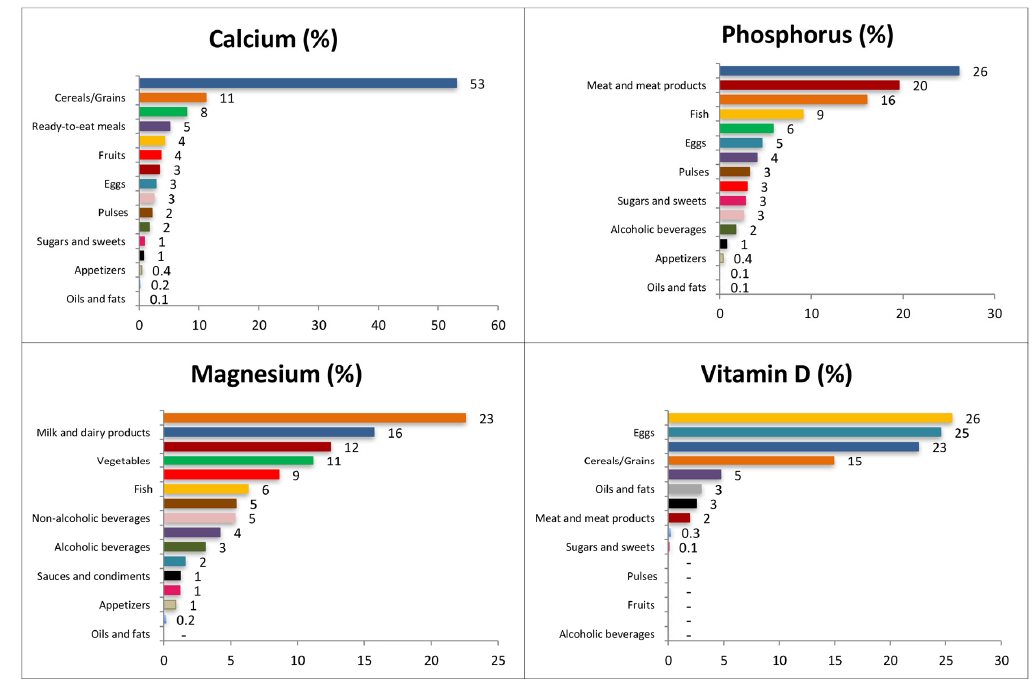
Figure 1. Contribution of food categories to the daily calcium, phosphorus, magnesium and vitamin D reported intake in the ANIBES Study population.